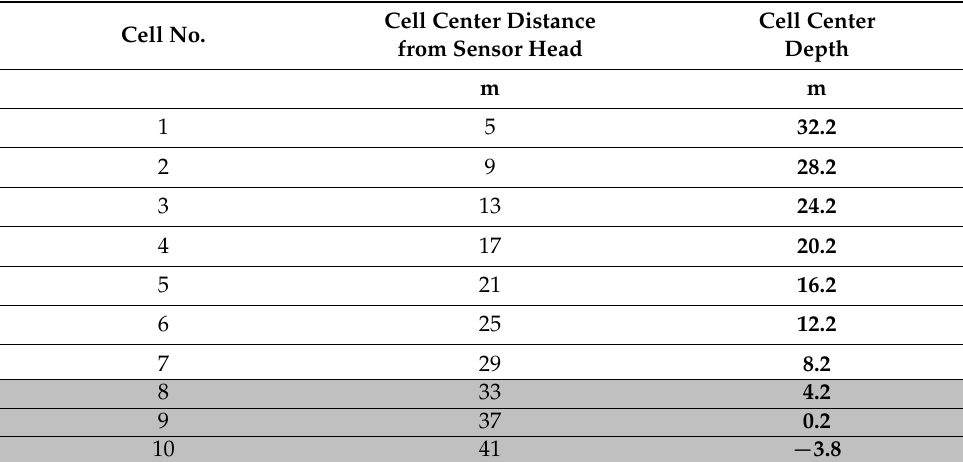
Table 1. Actual depths at which the centers of the ADCP measurement cells are located: depths for which the current measurements were not considered valid are shown in gray background. Negative depth indicates the cell whose center is in the air, above the surface of the sea. Cell Center Distance Cell No. from Sensor Head Depth Cell No. m